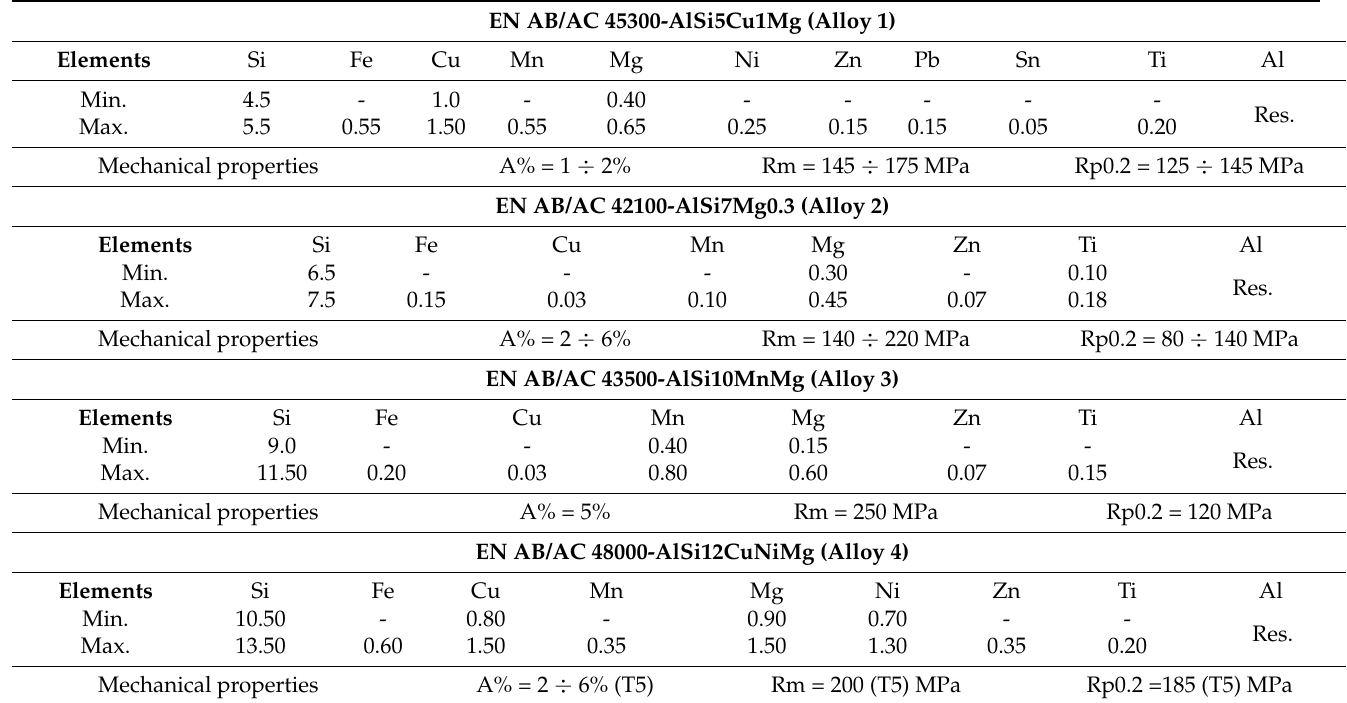
Table 2. Alloys’ composition from regulation EN 1706 and technical